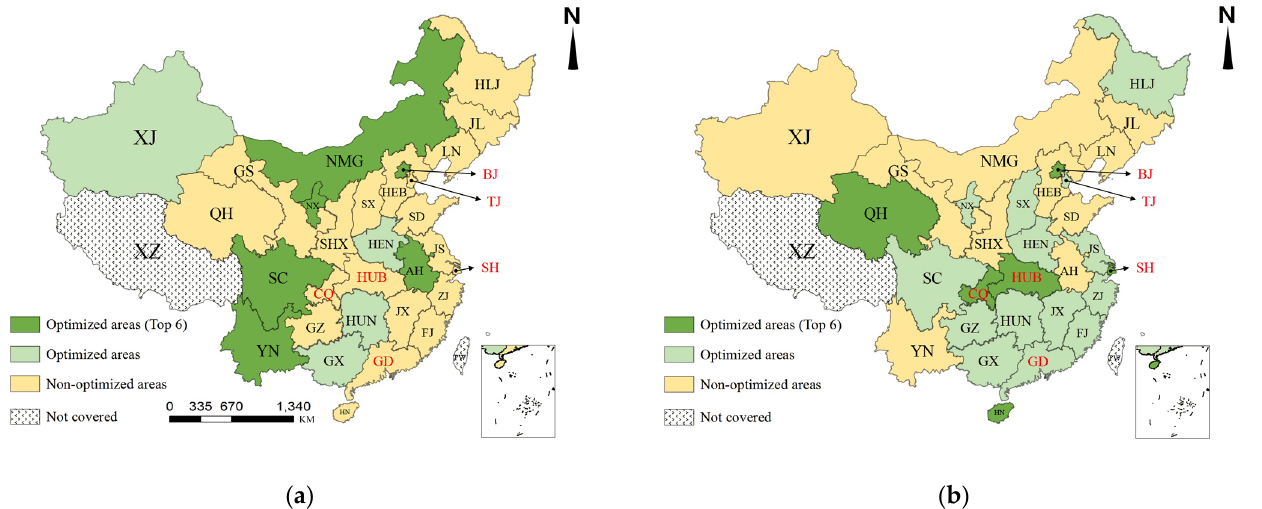
Figure 7. Spatio-temporal evolution of land use transition at the green development dimension. ( a ) Differences between the CETS implementation process and before implementation; ( b ) differences between the CETS post-implementation and implementation process.